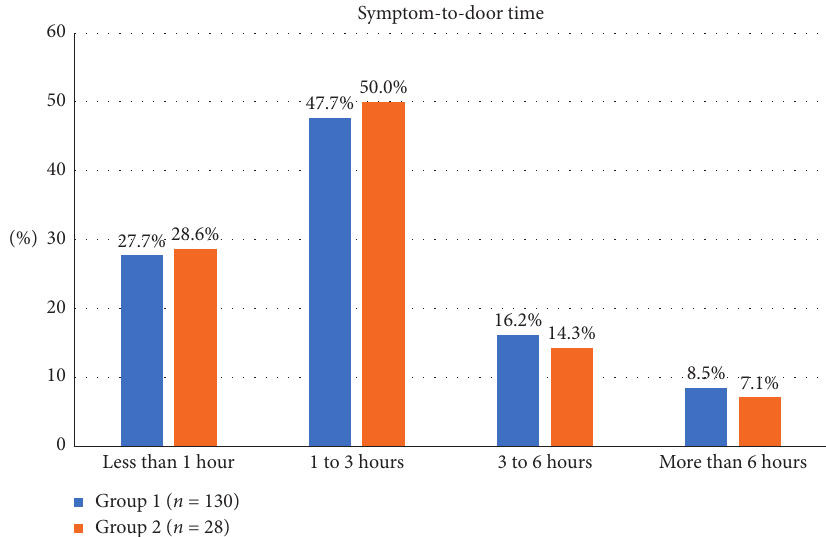
Figure 1: Distribution of symptom-to-door time between the two groups.